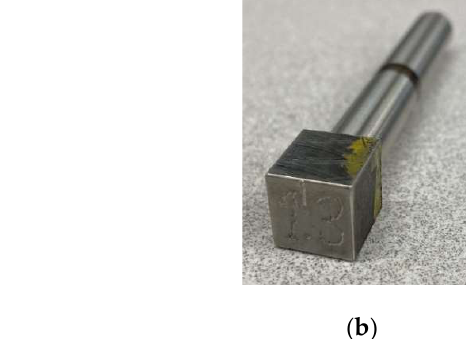
Figure 2. ( a ) Illustration of how the cuboid samples were cut from the cold-rolled samples. ( b ) Photograph of the sample after turning, where some part of the original cuboid was left untouched to keep track of the material axes.